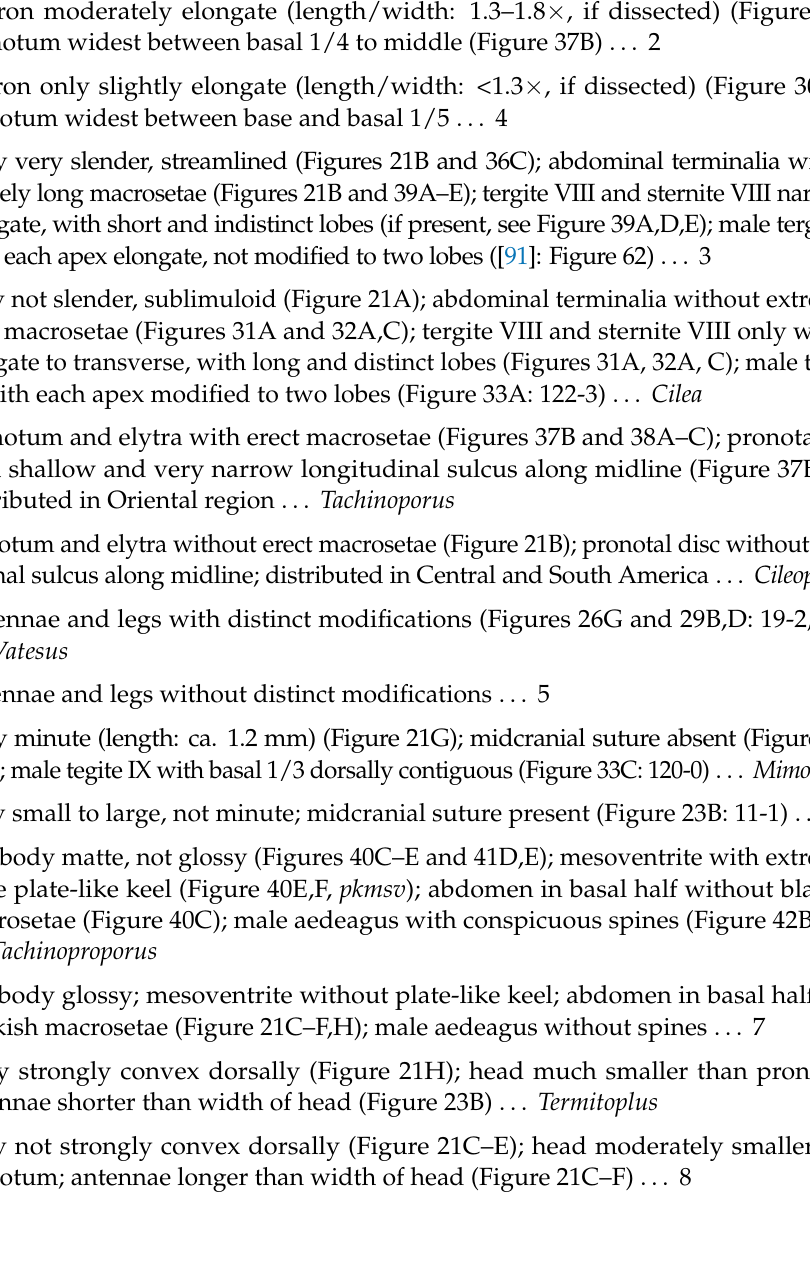
Body not strongly convex dorsally (Figure 21C–E); head moderately smaller than pronotum; antennae longer than width of head (Figure 21C–F) . . .